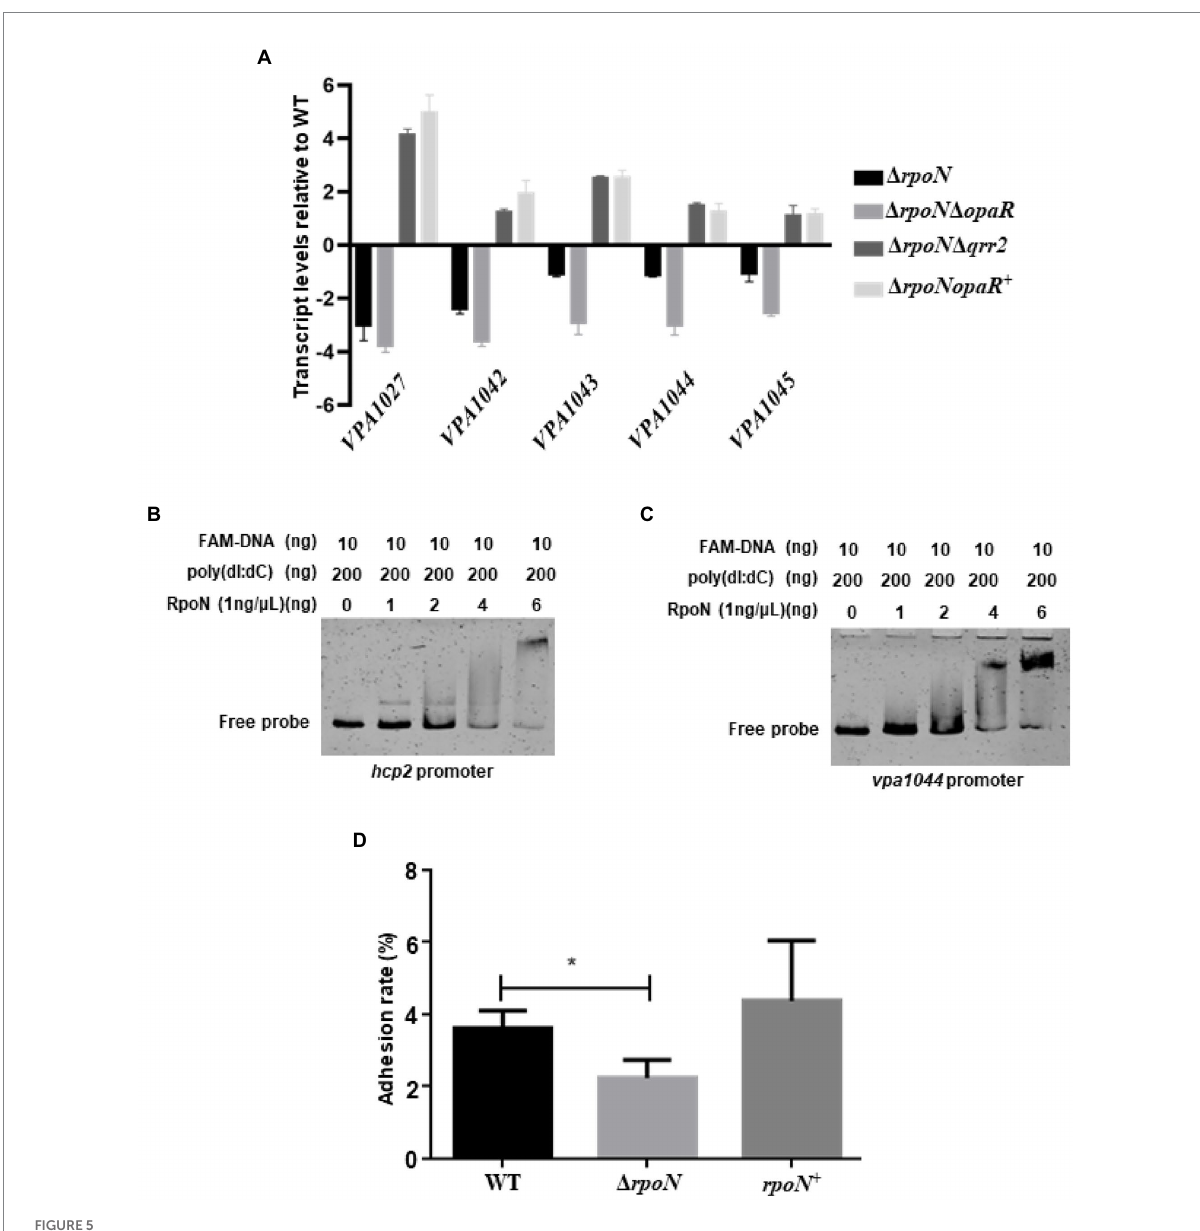
FIGURE 5 The RpoN directly regulates the expression of T6SS2 to mediate the adhesion of V. parahaemolyticus to HeLa cells. (A) qRT-PCR analysis of the expression levels of genes located in T6SS2 in WT, Δ rpoN , Δ rpoN Δ opaR , Δ rpoN Δ qrr2 and Δ rpoNopaR + strains. The data are presented as the mean ± SD ( n = 3). Student’s t test analyzes the different mutant strains compared to WT, and all the p-value lower than 0.001. (B,C) EMSA analysis of the specific binding of RpoN protein to the promoters of hcp2 (B) and VPA1044 (C) . (D) Adhesion analysis of WT, Δ rpoN , and rpoN + strains to HeLa cell monolayers. The data are presented as the mean ± SD ( n = 3), * p < 0.05, Student’s t test analyzes Δ rpoN compared to